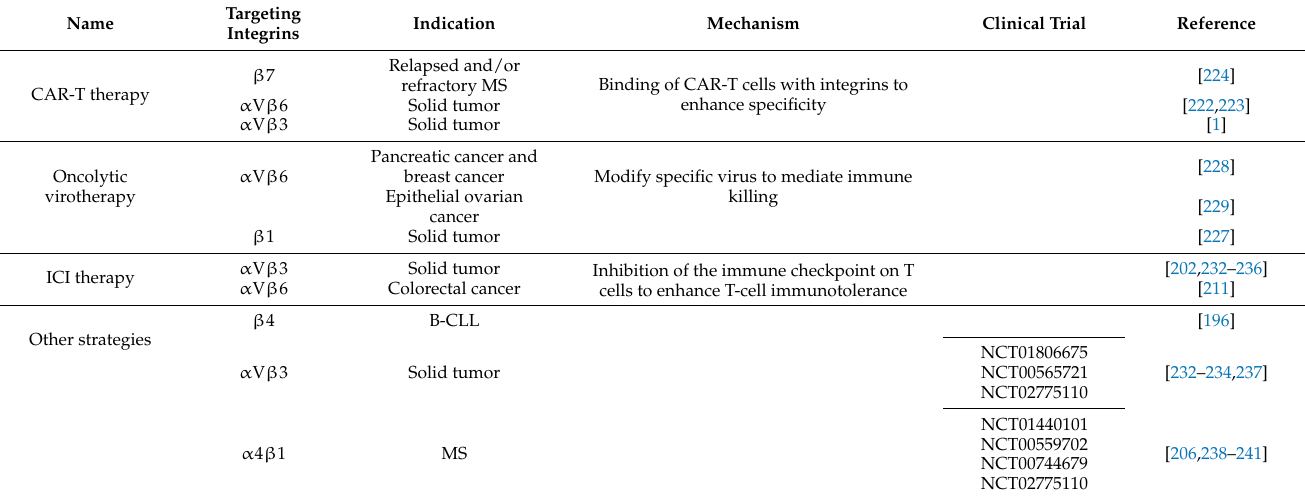
Table 2. Integrin-targeted immunotherapies in clinical trials for cancer